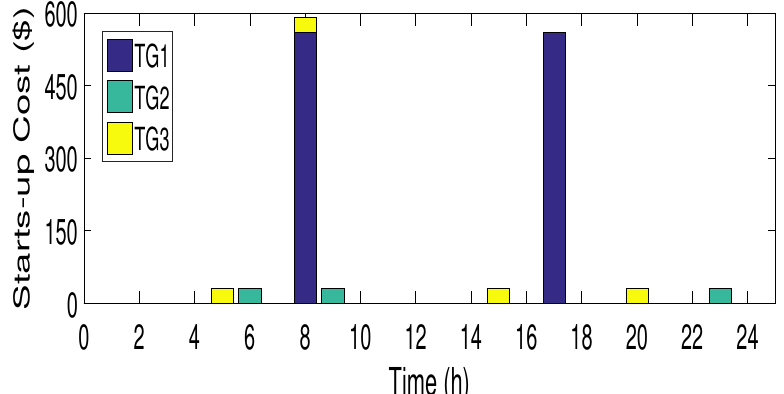
Figure 16. Scheduled reserve power in case 2.